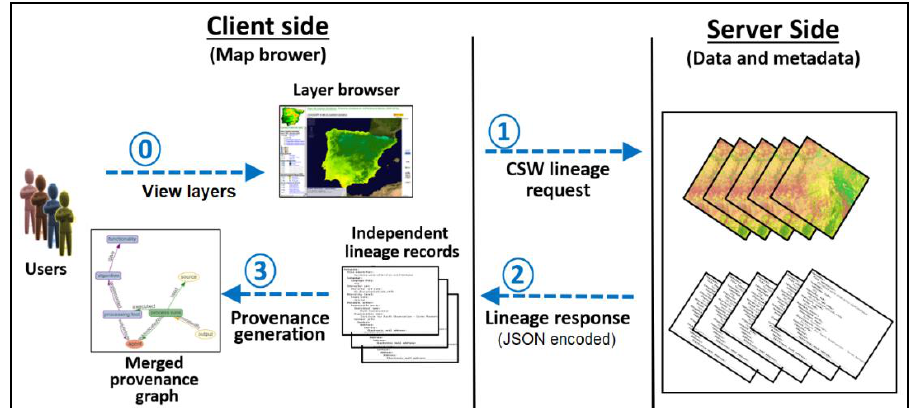
Figure 6. Provenance Web mapping system step by step. A Catalogue Service for the Web (CSW) lineage request (1) to the server allows the independent lineage of each requested dataset to be retrieved (2). Finally, the client generates the provenance graph (3).